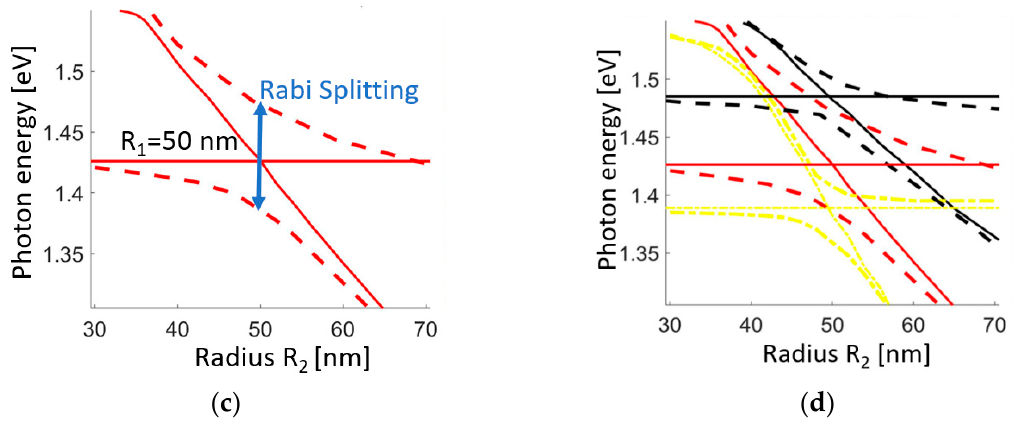
Figure 1. ( a ) Schematic of the proposed hybrid metasurface under consideration, where the unit cell consists of two elements (nanopillars). Each element has four nanodisks: two plasmonic made of silver and two made of high-refractive-index material, silicon. The nanodisks are of height H = 120 nm and radii R 1 = 50 nm (fixed) and R 2 , varied from 30 to 70 nm. The pairs are arranged in periodic array with periods P x = P y = P = 550 nm. The array is illuminated with the x -polarized light at the normal angle. The substrate and superstrate materials are silica. Considering the center of the unit cell has coordinates (0, 0), the first element has coordinates ( − P x /4, − P y /4), and the second element has coordinates ( P x /4, P y /4). ( b ) Numerical results and mode contours are for modeling the proposed nanostructure: The simulated absorption spectra versus radius of nanoantenna showing sextuple Fano resonances and triple Rabi splitting. It shows quintuple BICs in the nanostructure. Bound states in the continuum are shown in red circles due to the collapse of the widths of Fano resonances observed in the nanostructure. Inset: Fano profile of the mode at ~1.38 eV for R 2 = 48 nm. ( c ) Contours of one mode pair. The horizontal line corresponds to the mode in Element #1 (unchanged due to the constant R 1 = 50 nm), and the diagonal line corresponds to the mode in Element #2 that changes along with R 2 . The solid lines are the results for a single element in the unit cell, while the dashed lines are the results of modeling two elements. ( d ) Contours of three pairs of the nanostructure modes.